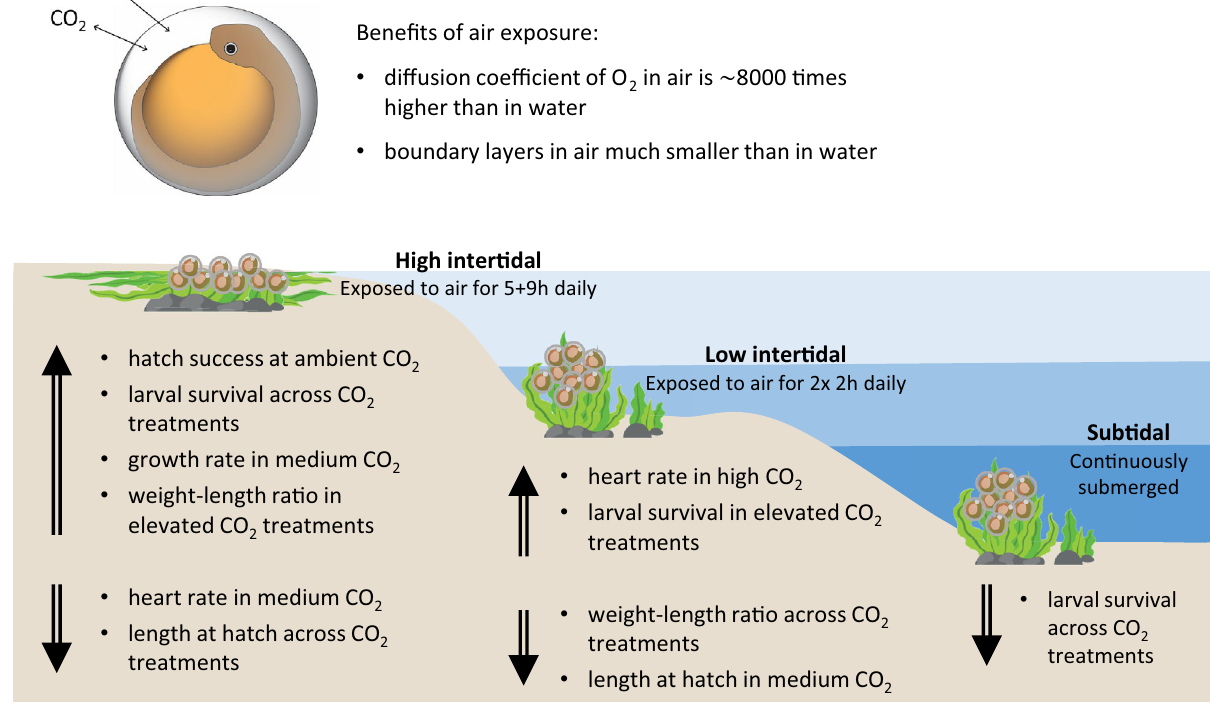
Figure 1. Graphical abstract summarizing the findings on the combined effects of intertidal air exposure and